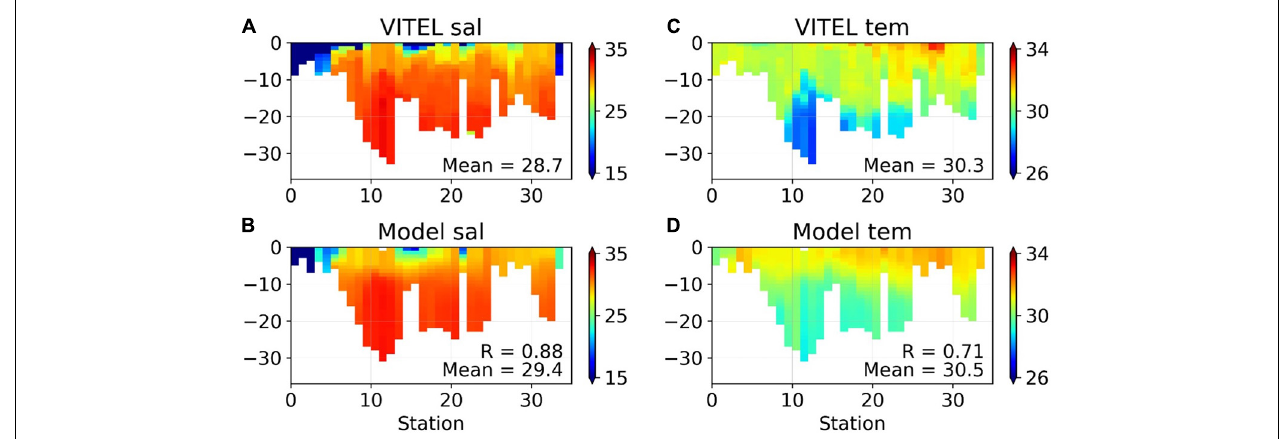
FIGURE 7 | Profiles of salinity from VITEL data (A) from GOT_REF (B) . (C,D) Same but for